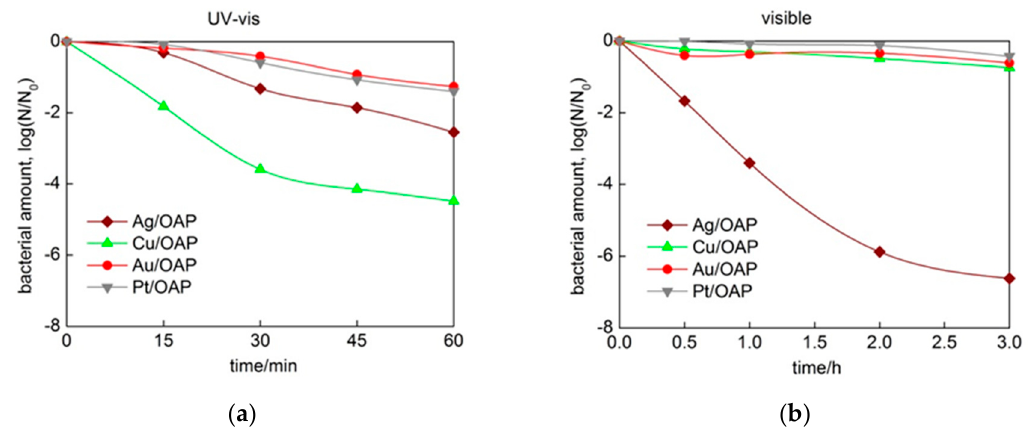
Figure 6. Antibacterial activity of OAP samples modified with NMNPs under: ( a ) UV / vis irradiation and ( b ) vis irradiation; adapted with permission (after formatting) from [117]. Copyright 2017 Creative Commons Attribution. Table 1. Key-factors of antimicrobial properties of NM-modified titania